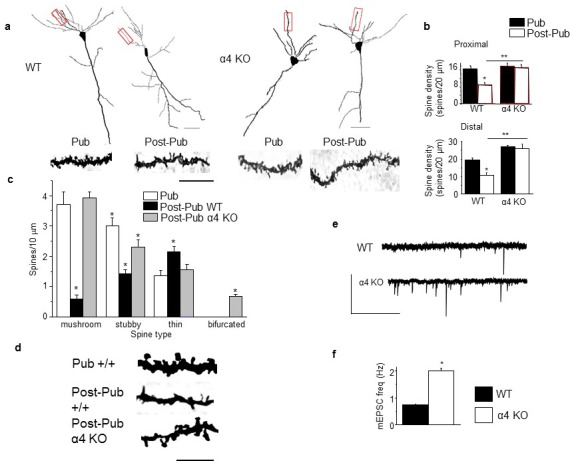
Synaptic pruning of CA1 hippocampus of adolescent female mice is prevented in the α4 knock-out.Pub, pubertal; post-Pub, post-pubertal. (a) CA1 hippocampal pyramidal cells, Pub and post-Pub (8-week old) WT and α4 KO female mouse hippocampus. Upper panel, neurolucida images, scale, 50 µm; lower panel, z-stack (100x) images; scale, 20 µm. Additional images and data from male mice provided in Figure 1—figure supplement 1 and Figure 1—figure supplement 2, respectively. Source data for all figures are available as separate files. (b) Averaged data for spine density, Proximal (left), WT, t-test, t(41)=7.15, p<0.0001*, power=1; n= 21–22 neurons (5–6 mice)/group; α4 KO, t-test, t(47)=0.43, P=0.67; n= 24–25 neurons (6 mice)/group; post-Pub, WT vs. α4 KO, t-test, t(45)=5.8, p<0.0001*; Distal (right), WT, t-test, t(28)=5.73, p<0.0001, power=1*; n= 15 neurons (5–6 mice)/group; α4 KO, t-test, t(39)=2.11, P=0.04; n= 20–21 neurons (6 mice)/group; post-Pub, WT vs. α4 KO, t-test, t(33)=8.1, p<0.0001*. *p<0.05 vs. Pub; **p<0.05 vs. WT. (Figure 1—source data 1) (c) Quantification of spines according to type, *p<0.05 vs. other pubertal/genotype groups. Mushroom, ANOVA, F(2,54)=110.65, p<0.0001*, power=1; Stubby, ANOVA, F(2,54)=23.1, p<0.0001, power=1; Thin, ANOVA, F(2,54)=9.29, p=0.0003*, power=0.94; Bifurcated, ANOVA, F(2,54)=39, p<0.0001*, power=1; (n=19 neurons, 5 mice/group). *p<0.05 vs. other groups. (Figure 1—source data 2) (d) Representative high-contrast z-stack images; scale, 10 µm. (e) Representative mEPSCs, post-Pub WT and α4 KO. Scale, 50pA, 10 s. (f) Averaged data, mEPSC frequency; *t-test, t(16)=11.4, p<0.0001*, power=1; n= 8–10 cells (mice)/group. (Figure 1—source data 2)DOI:
http://dx.doi.org/10.7554/eLife.15106.00310.7554/eLife.15106.004Figure 1—source data 1.Spine counts/20 μm on dendrites of CA1 hippocampal pyramidal cells for Figure 1b for wild-type (WT) and α4 knock-out (KO) female mice assessed at puberty (Pub, PND 35, identified by vaginal opening) and post-puberty (Post-pub, PND 56).DOI:
http://dx.doi.org/10.7554/eLife.15106.00410.7554/eLife.15106.005Figure 1—source data 2.Spine counts/10 μm for different spine-types on dendrites of CA1 hippocampal pyramidal cells for Figure 1c for Pub and Post-pub WT and Post-pub α4 KO. Spines were identified as: mushroom, stubby, thin or bifurcated (Bif).DOI:
http://dx.doi.org/10.7554/eLife.15106.00510.7554/eLife.15106.006Figure 1—source data 3.Figure 1f. mEPSC frequency, # mEPSCs/s recorded from CA1 hippocampal pyramidal cells using whole cell patch clamp techniques for post-pubertal WT (left) and α4 KO mice.